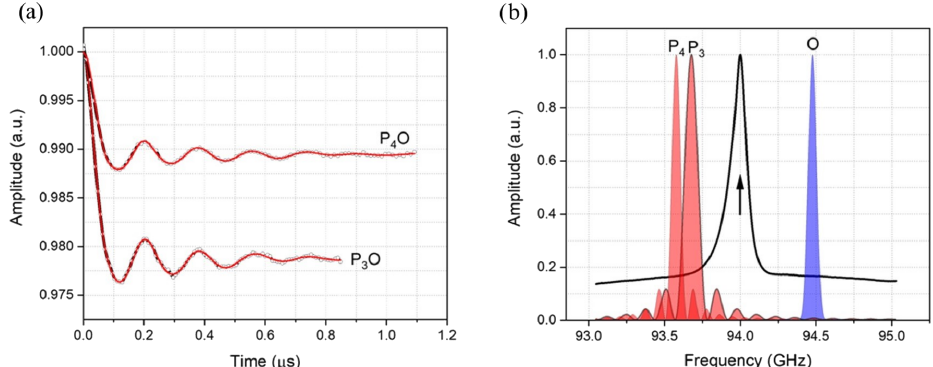
Figure 7. (a) Background-corrected DEER data (black curves) of Gd ruler (2.1nm) recorded with different offsets between pump and observer pulses together with fits (red curves) obtained by DeerAnalysis (2019) (Jeschke et al., 2006). (b) Excitation profiles of the pump (P) and observer (O) pulses at different frequency offsets. The corresponding frequency offsets are P 3 O = 800MHz and P 4 O = 900MHz. The black arrow indicates the position of 94GHz, the nominal centre frequency of our W-band EIK amplifier, which has a bandwidth of just less than